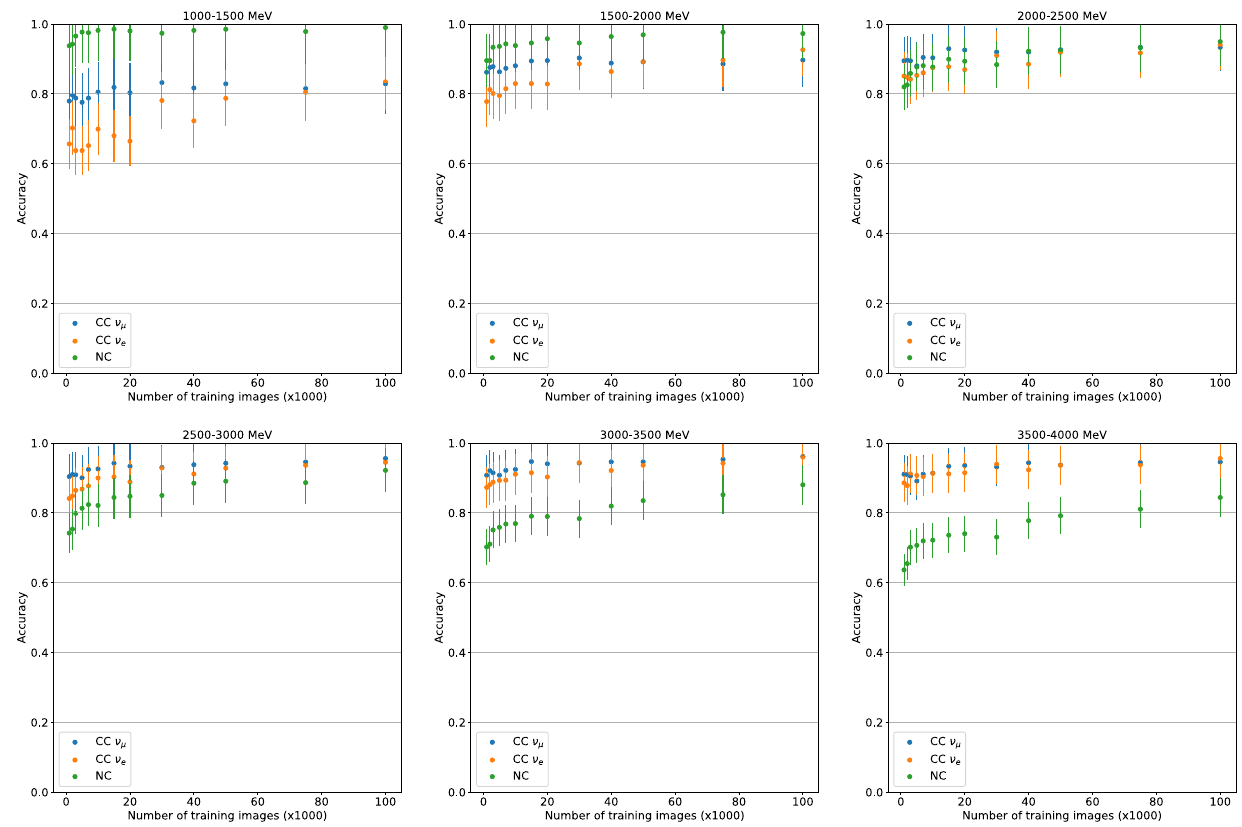
Fig. 7 The classification accuracy for each interaction type as a function of the training sample size for transfer learning all weights cases